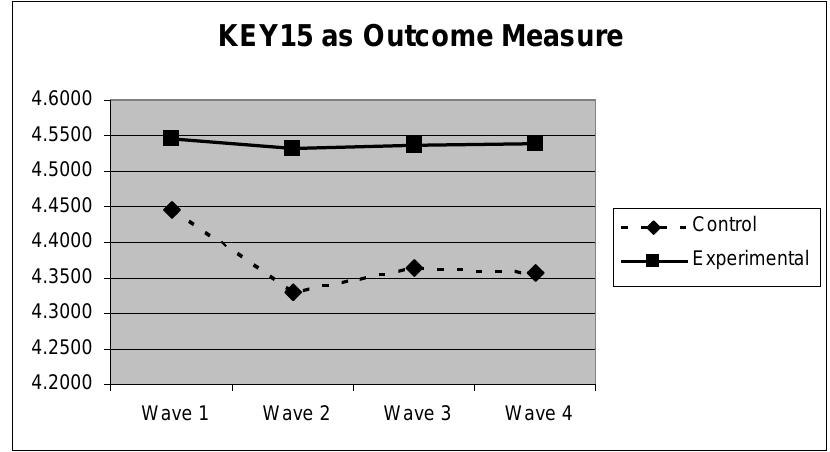
FIGURE 5 Growth trajectories in the experimental participants participating in the Tier 1 Program (and who regarded the program as beneficial) and control participants using KEY15 as an outcome indicator.